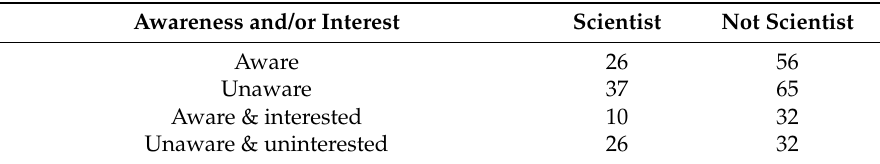
Table 6. Interest and awareness and science